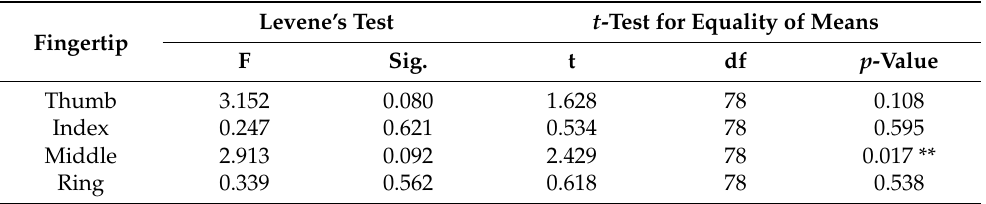
Table 9. Independent samples t -test for comparison finger force in grip subscale, with respect to different groups of age (18–32 years) and (45–72